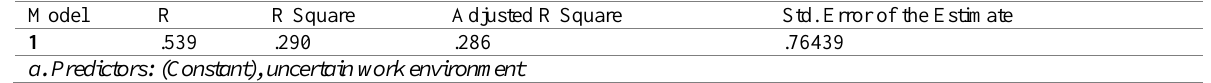
Table 11: Model summary for uncertain work environment on work engagement